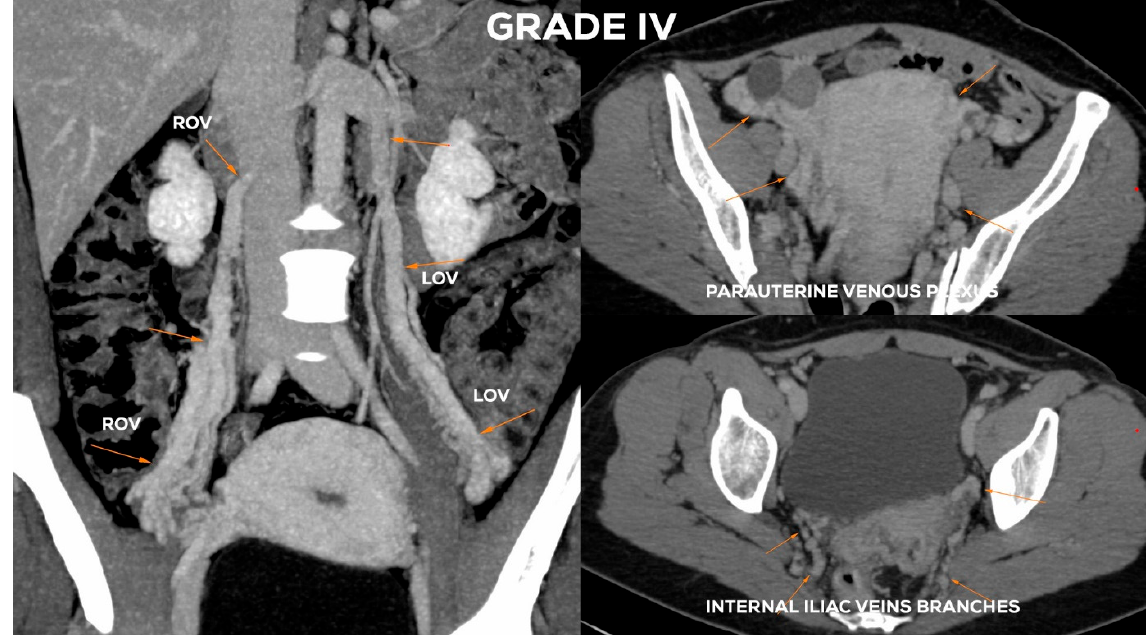
Figure 17. Typical findings in patient with Grade IV ovarian veins insufficiency seen on a CTV images in coronal and axial planes.